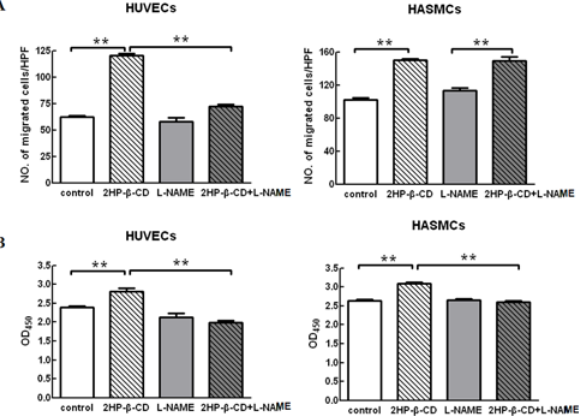
Fig 3. Effects of L-NAME on migration and proliferation of HUVECs and HASMCs induced by 2HP- β - CD. HUVECs and HASMCs were pretreated with/without 1 mM L-NAME followed by incubation with/without 10 -8 M 2HP- β -CD. Migration (A, 5 h) and proliferation (B, 72 h) of the cells were assessed as described in “ Materials and Methods ” . Data represent the mean ± S.E.M. ( n = 3 experiments). * p < 0.05, ** p < 0.01.